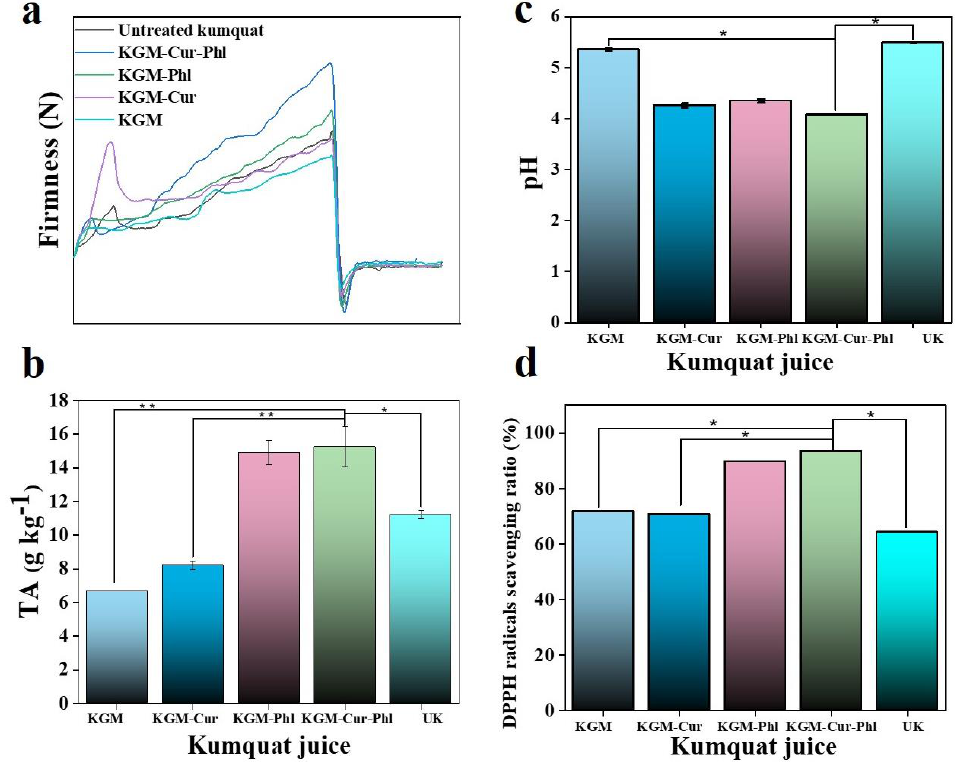
Figure 5 . ( a ) Firmness of kumquats on day 12. ( b ) The titratable acid (TA) value of the corresponding kumquat juice. ( c ) The pH values of corresponding kumquat juice. ( d ) The DPPH radicals scavenging ratio of kumquats juice. UK means untreated kumquat. * p < 0.05, ** p < 0.01.